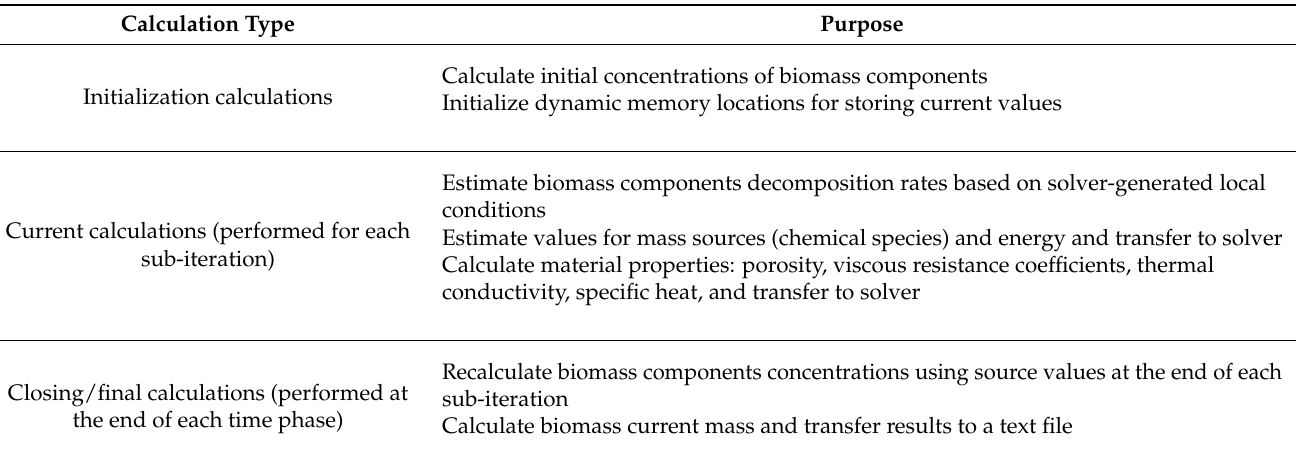
Table 1. Main calculations performed by the user-defined function